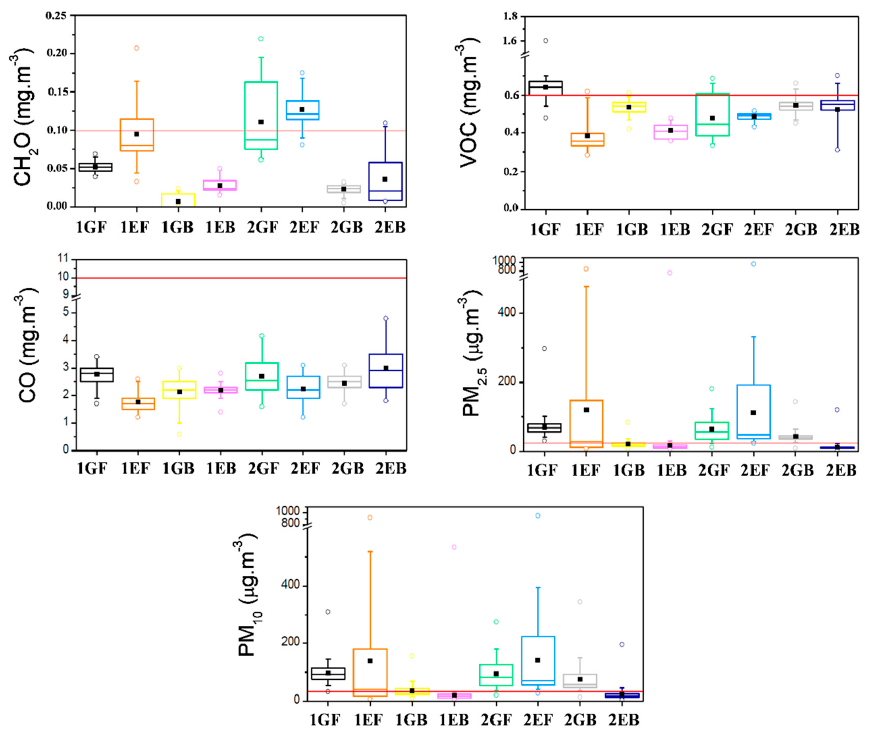
Figure 11. Selected indoor air pollutants for the studied cooking scenarios: 1GF—House 1 | Gas |